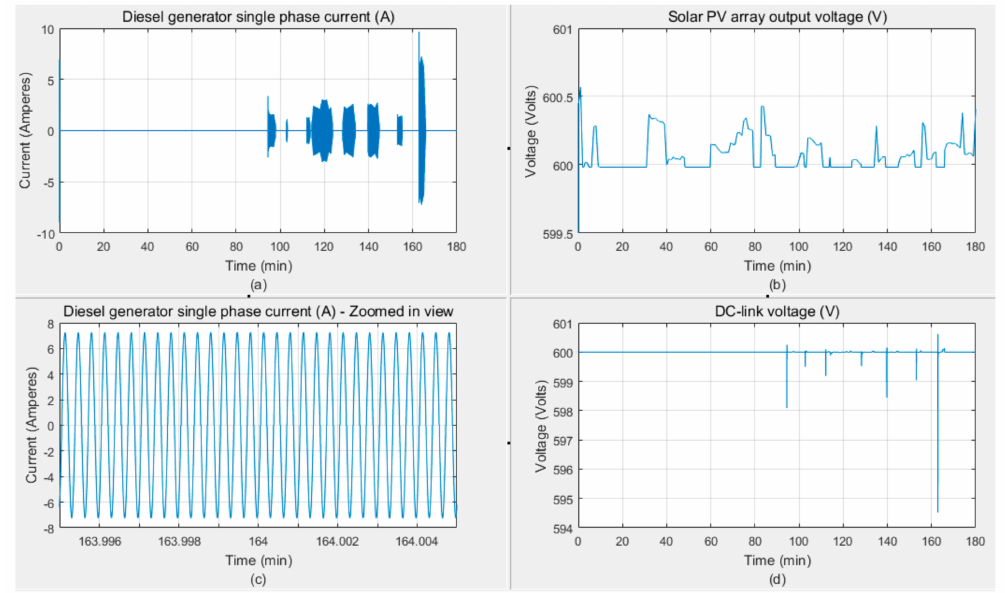
Figure 24. System parameters. ( a ) Diesel generator single-phase current. ( b ) PV array output voltage. ( c ) Diesel generator single-phase current- zoomed-in view. ( d ) DC-link